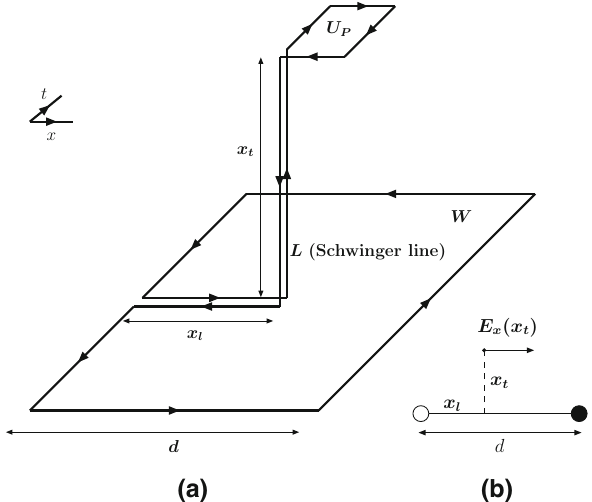
Fig. 1 a The connected correlator given in Eq. (1) between the plaque- tte U P and the Wilson loop (subtraction in ρ conn not explicitly drawn). W ,μν b The longitudinal chromoelectric field E x ( x t ) relative to the position of the static sources (represented by the white and black circles), for a given value of the transverse distance x t